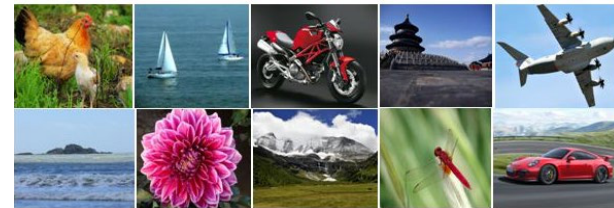
Figure 8. Sample Image of GHIM-10k database